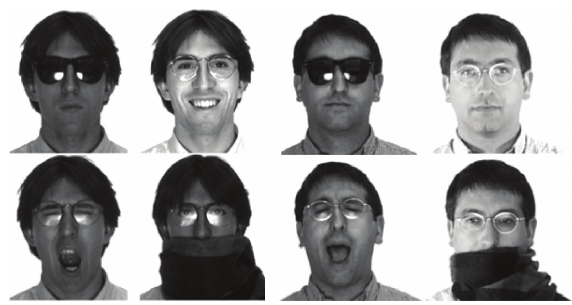
Figure 5: Example of images from the AR face database.